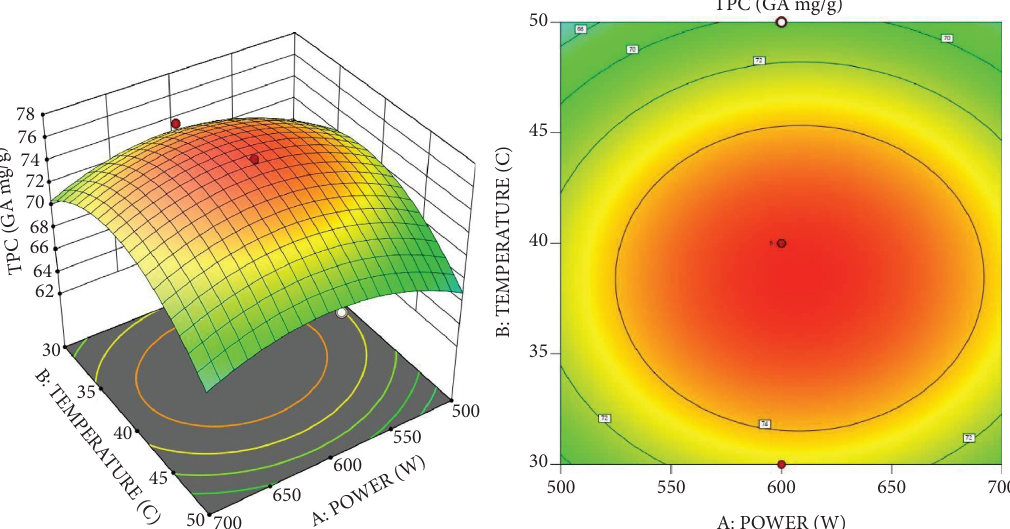
Figure 2: 3D and 2D plots of total phenol content against power and temperature.